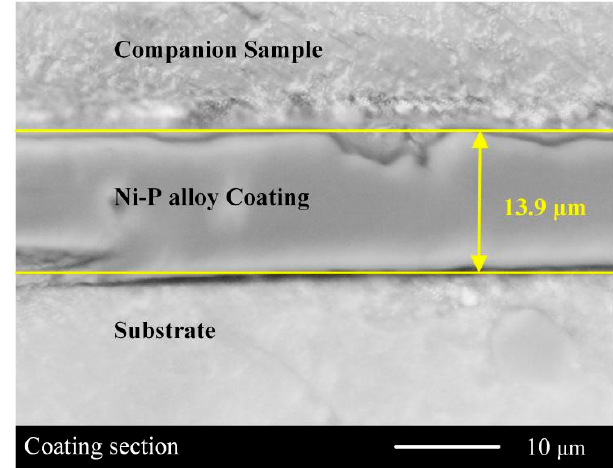
Figure 10. Section of Ni-P alloy coating.